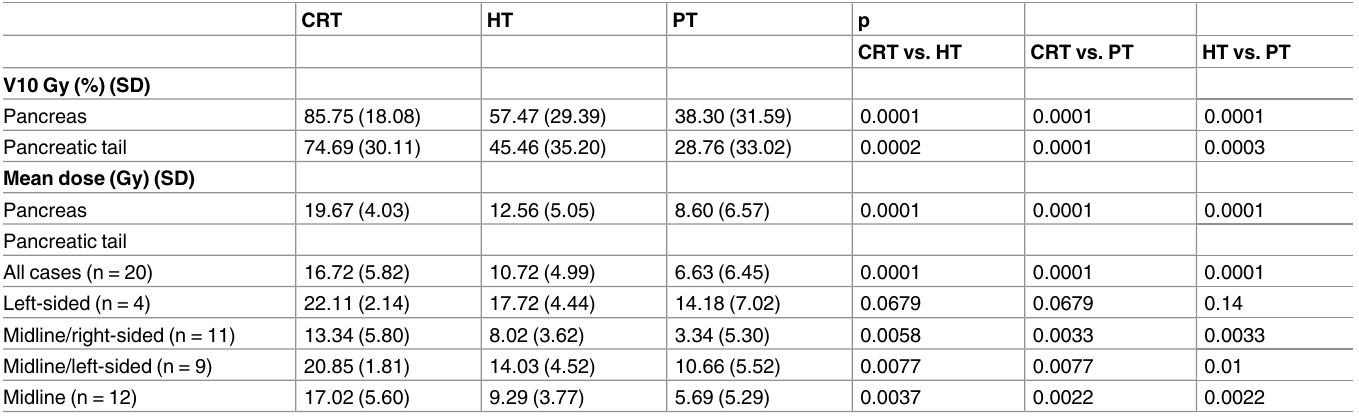
Table 2. Dose to the whole pancreas and to the pancreatic tail in all cases and by tumor